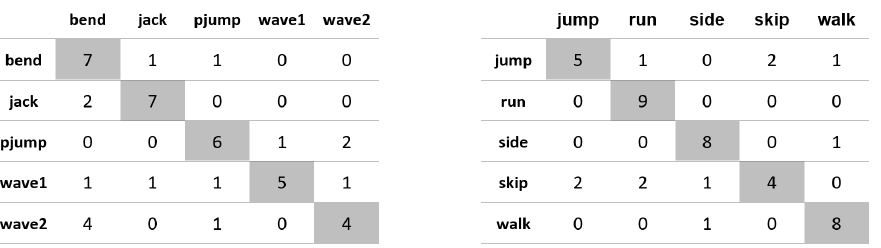
Figure A32. Confusion matrices for the experiment using the ‘upper-occlusion’ database, MBR length and C1 correlation.